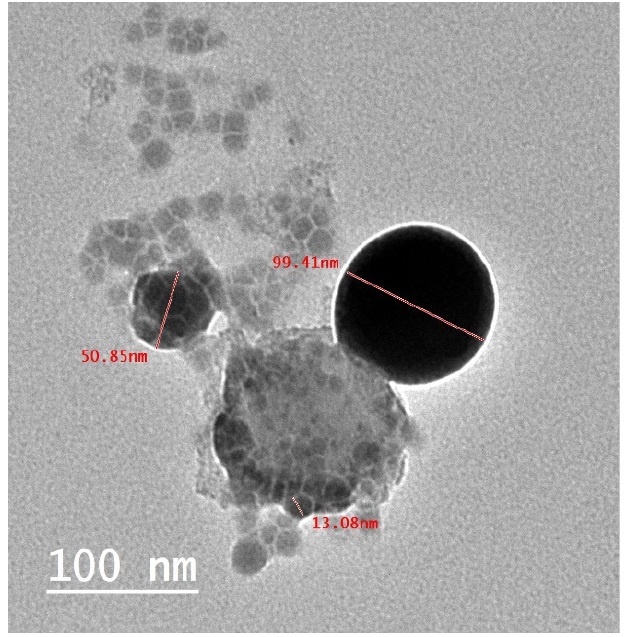
Figure 5. TEM image showed a spherical shape of biofabricated SeNPs by A.